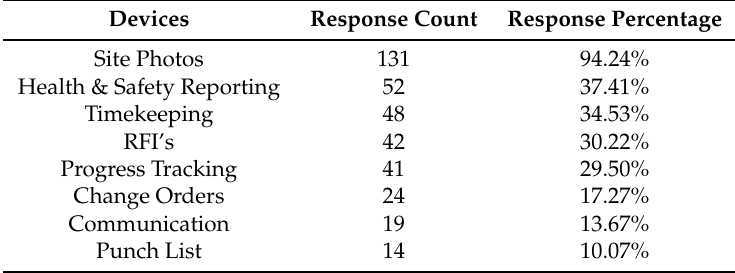
Table 3. Application Areas Used for New Zealand Construction